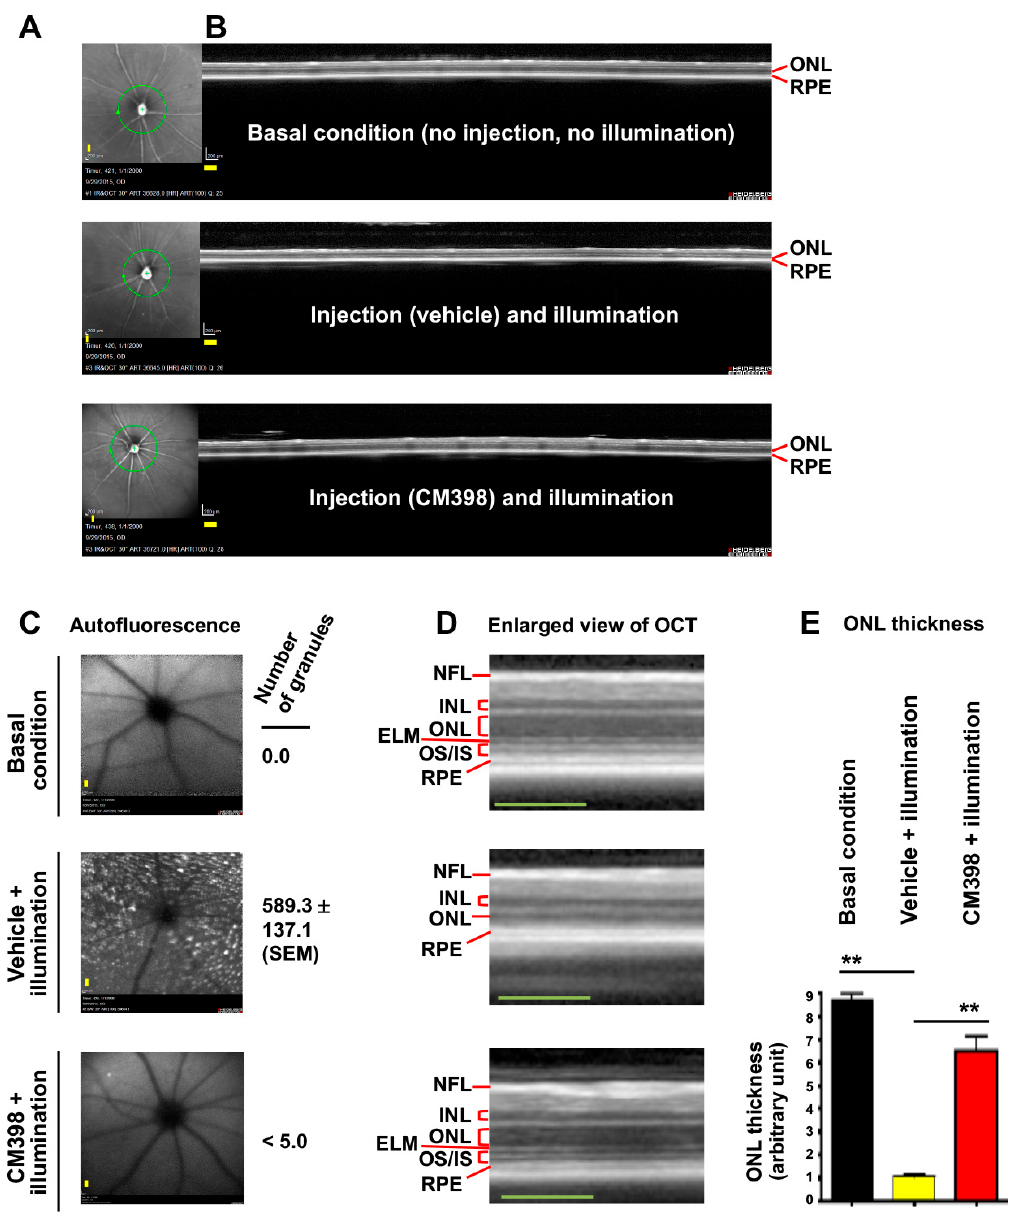
Figure 3. Effect of pretreatment with CM398 on photoreceptor loss induced by retinal illumination in Abca4 − / − Rdh8 − / − mice. Mice received a one-time i.p. injection of CM398 (3 mg/kg) 30 min prior to retinal illumination (10,000 lux for 30 min). Retinal OCTs were recorded after housing the mice in a room with red dim light for 7 days. The mice were then euthanized for retinal histology (see Figure 1B). Each scale bar (yellow) in the OCT images represents 200 μ m. ( A ) Fundus photography. The green circle around the optic nerve head indicates the location of the vertical SD-OCT scan. ( B ) Full image of vertical SD-OCT scan. The scale (200 μ m) and experiment date are recorded at the lower left corner. ( C ) Scanning laser ophthalmoscopy. The number of autofluorescence granules was quantified using Image-J. Mean ± SEM, n = 6 mouse eyes. ( D ) Enlarged view of the OCT image in B. RPE: retinal pigment epithelium. OS/IS: outer/inner segment. ELM: external limiting membrane. ONL: outer nuclear layer. INL: inner nuclear layer. NFL: nerve fiber layer. ( E ) Quantification for A. ONL thickness was measured using Image-J. The values from 3–4 OCT images of the same eye were averaged, and the means from all 6 eyes from 3 animals were then averaged to calculate each group’s mean and standard error of the mean (SEM). Data are presented as mean ± SEM, n = 6 mouse eyes. One-way ANOVA and Tukey test, ** p <